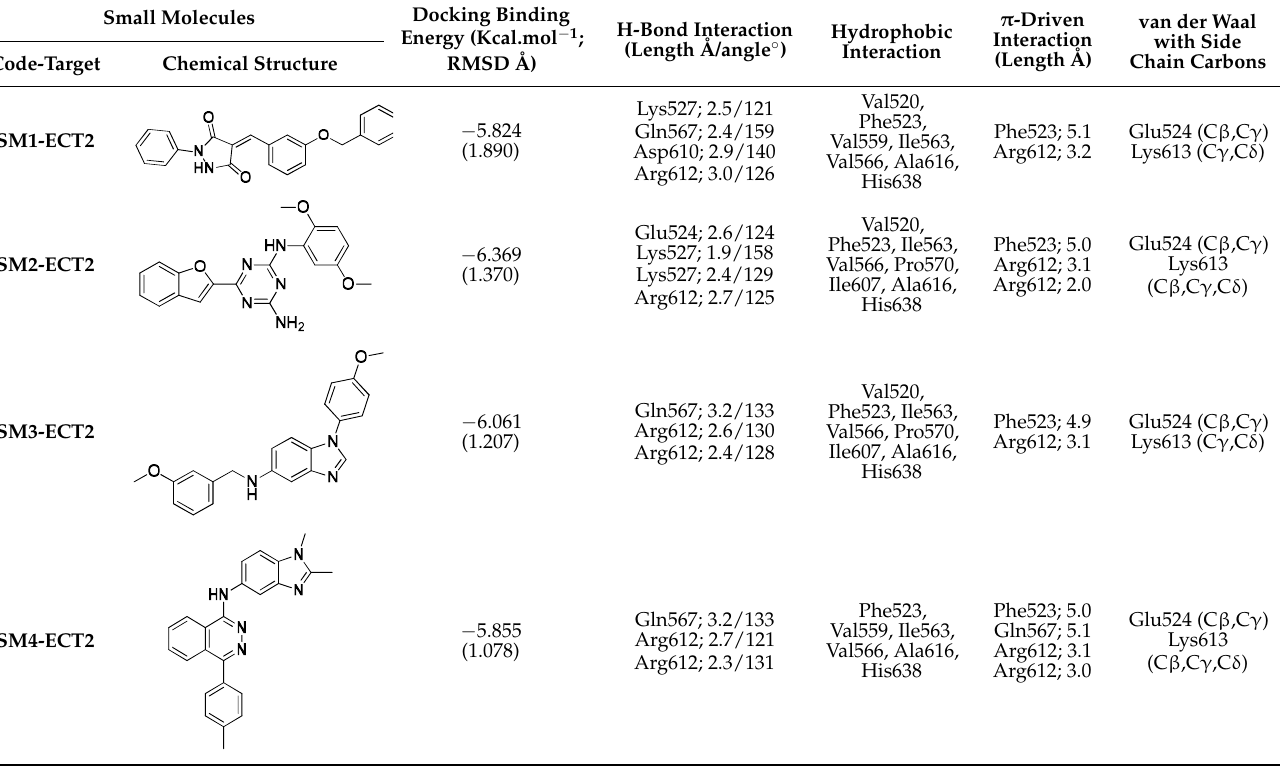
Figure 11. Docked binding modes and interactions for investigated small molecules at ECT2 catalytic DH-PH interface. ( A ) Overlay of docked small molecules (blue sticks) at ECT2 catalytic interface (PDB; 6L30) shown in surface representation and colored according to domain (DH and PH domains as red and green, respectively). Zoomed image defines the assigned DH-PH interface endorsed by α 3, α 5, α 6 helices (DH domain) and α N, α C, β 1–4 sheet loops (PH domain). ( B – H ) Predicted binding modes of the docked ligands (blue sticks); ( B ) SM1, ( C ) SM2, ( D ) SM3, ( E ) SM4, ( F ) SM5, ( G ) SM6, and ( H ) SM7 at ECT2 catalytic interface binding site. ( I ) Replicated binding mode of SM1 at LARG RhoGEF (PDB; 1X86) as reported in the literature. Residues (lines) within a radius of 5 Å from the bounded ligands are displayed, colored with regard to their position at the catalytic domains and labeled with a sequence number. Black dashed lines represent the polar ligand–target interactions. Table 1. Dissected docking–binding interactions for small molecules at DH-PH catalytic interface of RhoGEF ECT2 and/or LARGE.